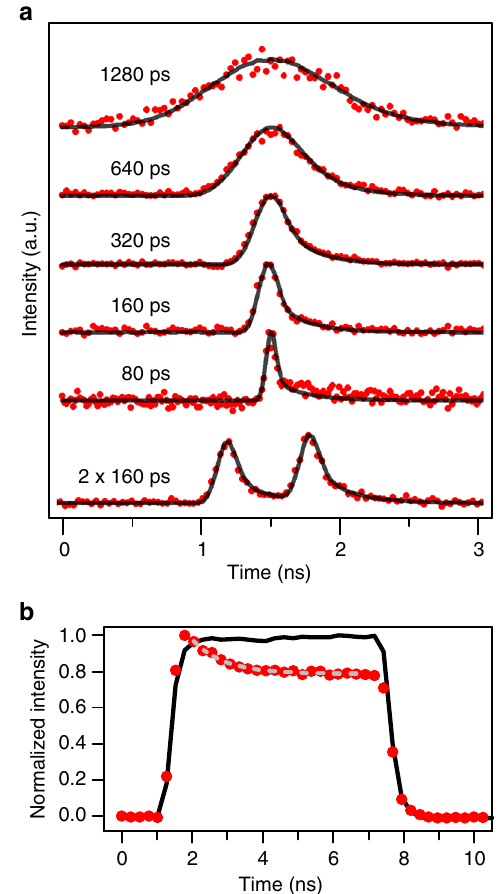
Fig. 4 Temporal tuning. Temporal pro fi le of the Raman emission at a δ = − 50 µ eV for a series of laser pulse widths and a double pulse; b δ = − 35 µ eV with a 6-ns square-wave pulse. Solid lines are the laser intensity and the red circles are the Raman intensity. All laser pulses in a are symmetric Gaussian pulses. The asymmetry in the measured spectra arises from the response of the detector. The smaller detuning in b and a laser power of 1 µ W were chosen to bring the equilibrium emission near saturation where the spin relaxation time should be the limiting factor (Supplementary Note 1). A value of 2.3 ns for the spin relaxation time was extracted from a fi t (dashed gray line), in agreement with the rise time of the second-order correlation function measured with cw excitation (Fig.